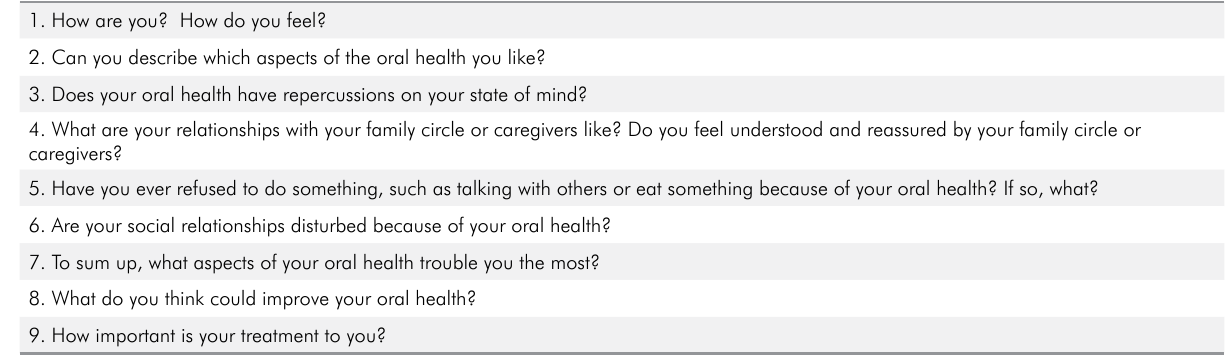
Table. Interview guide used in semi-directive interviews with persons with